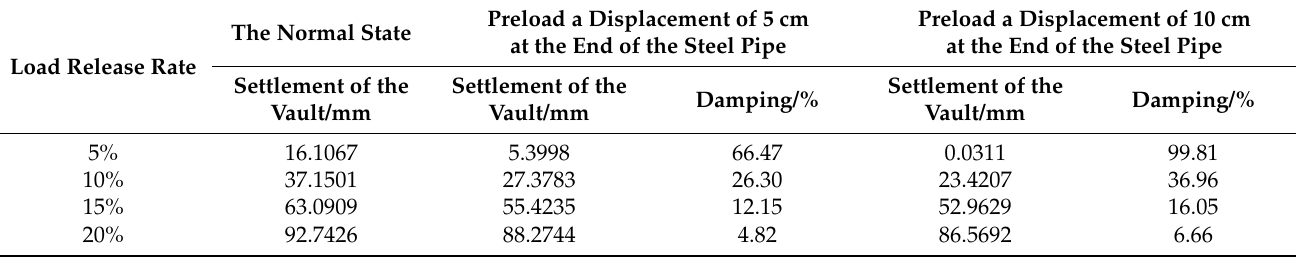
Table 4. The influence of four active bearing FSPs of 89 × 8 mm on settlement of the arch vault.